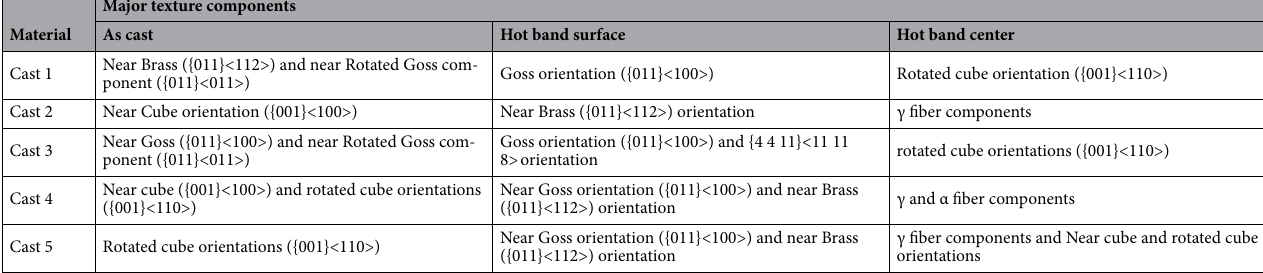
Table 3. Major texture components observed in the as cast and corresponding hot band